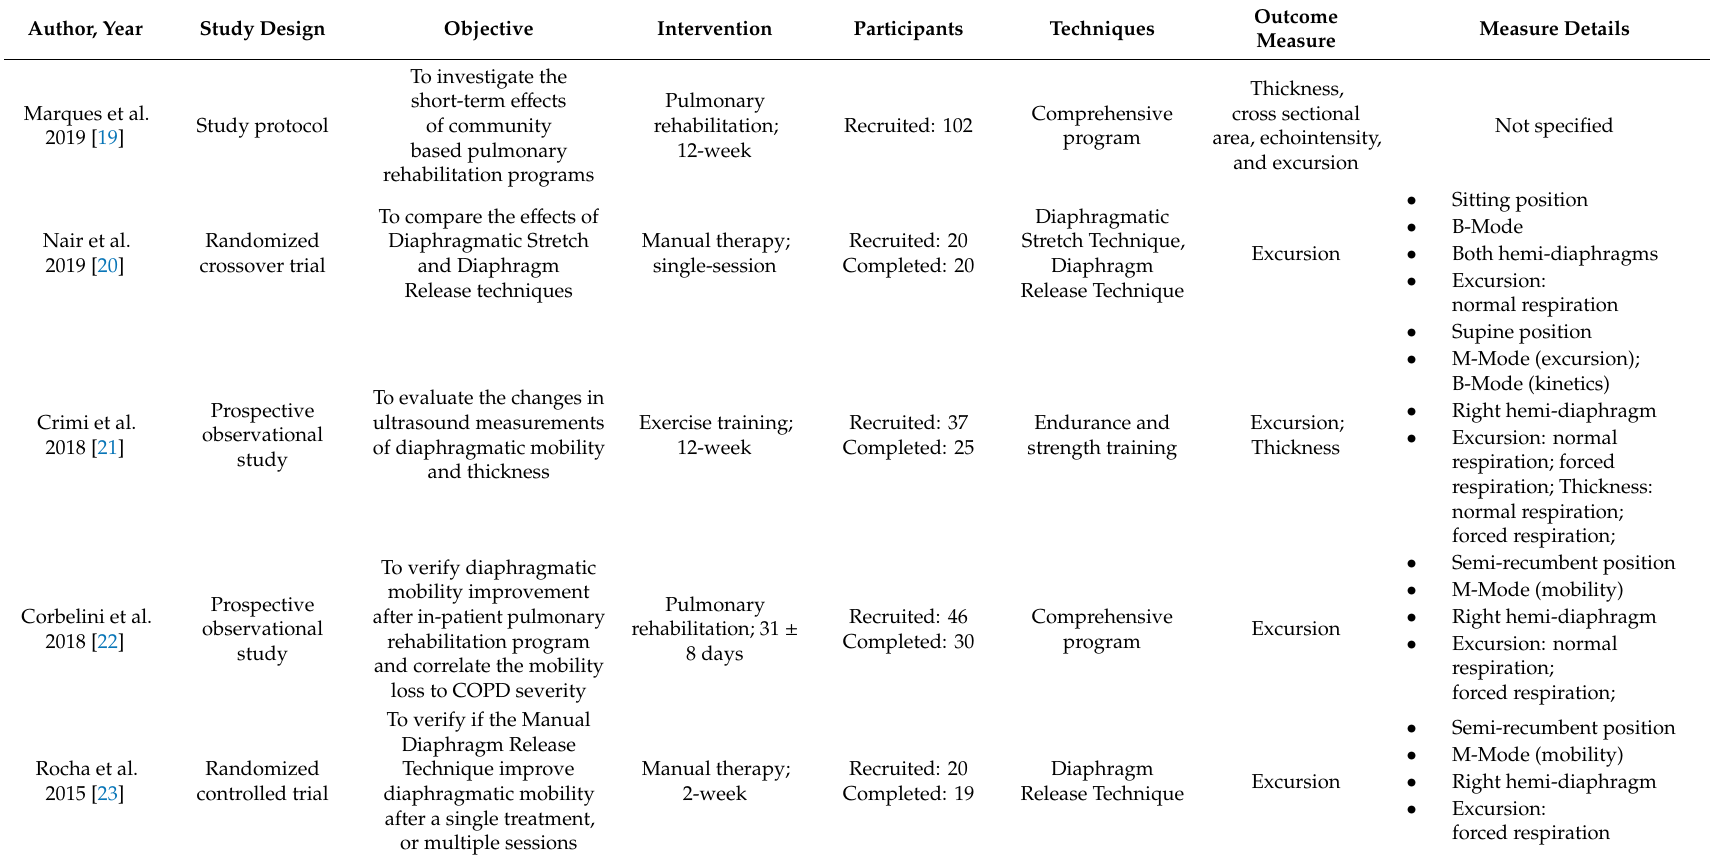
Table 1. Characteristics of the studies included in this